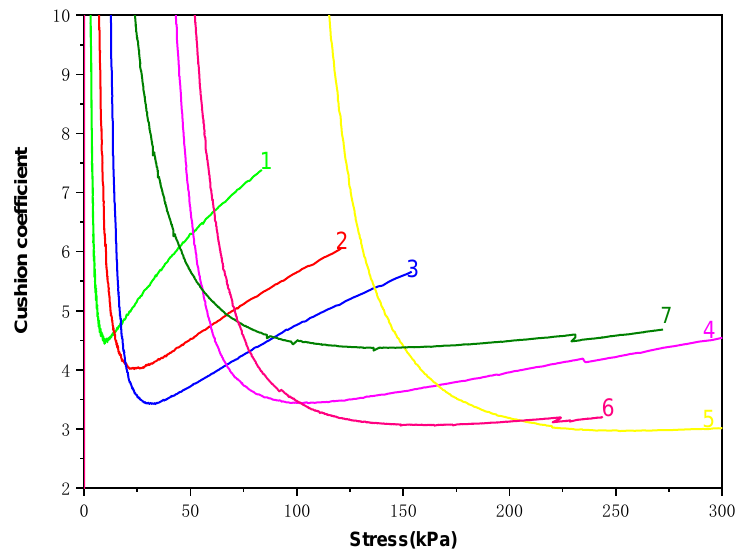
Figure 7. Cushion coefficient of materials as a function of stress, with different PVA contents.